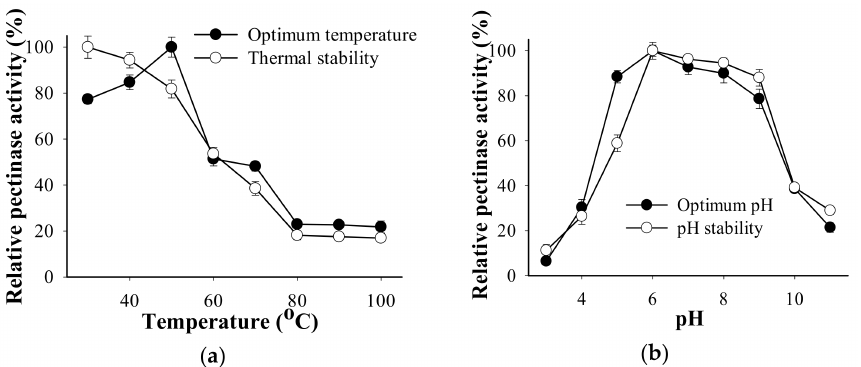
Figure 4. Effects of temperature and pH on the activity and stability of B. amyloliquefaciens TKU050 pectinase: ( a ) temperature; ( b ) pH. All data points are the mean and standard deviation.